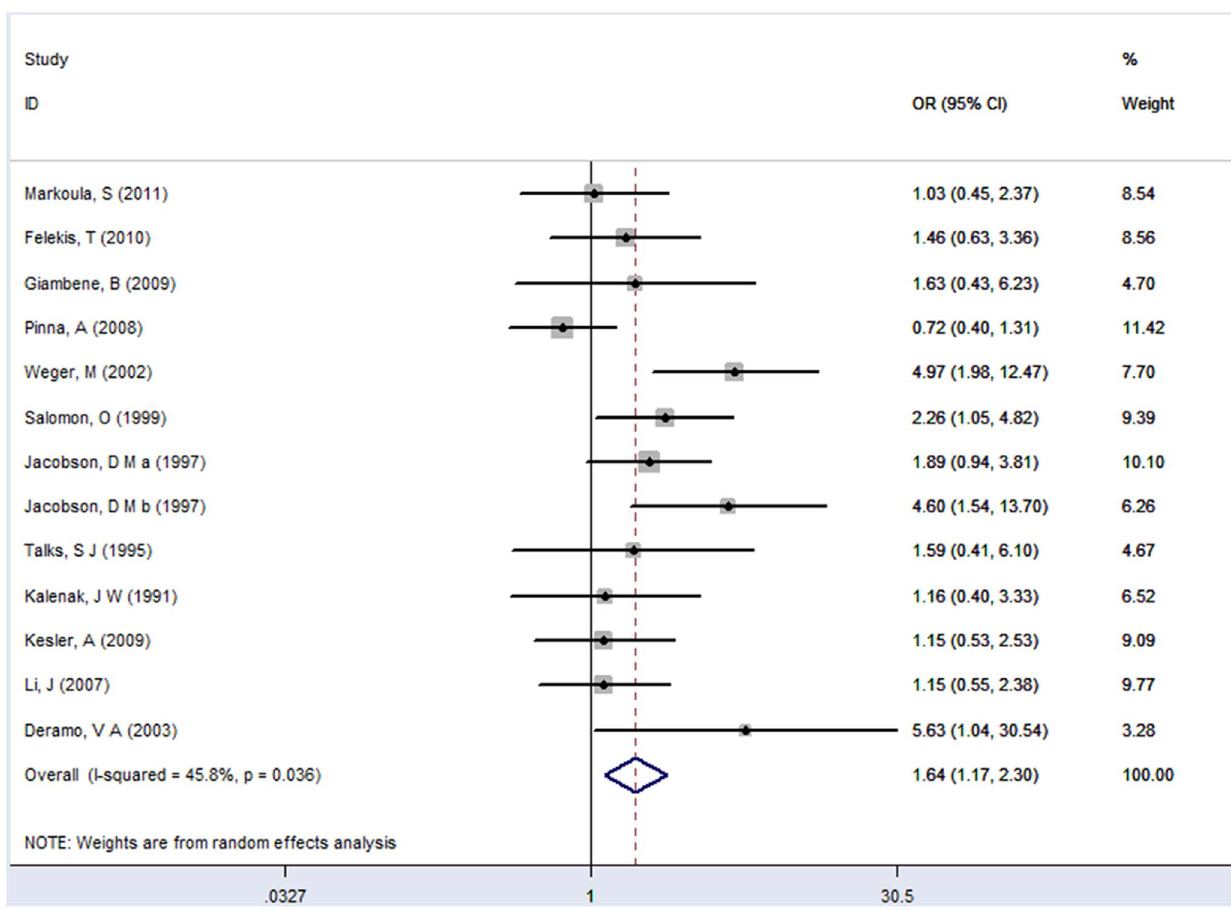
Figure 2. Random effects meta-analysis investigating the association of DM with NAION. CI= confidence interval; OR= odds ratio; DM= diabetes mellitus; NAION= nonarteritic anterior ischemic optic neuropathy.